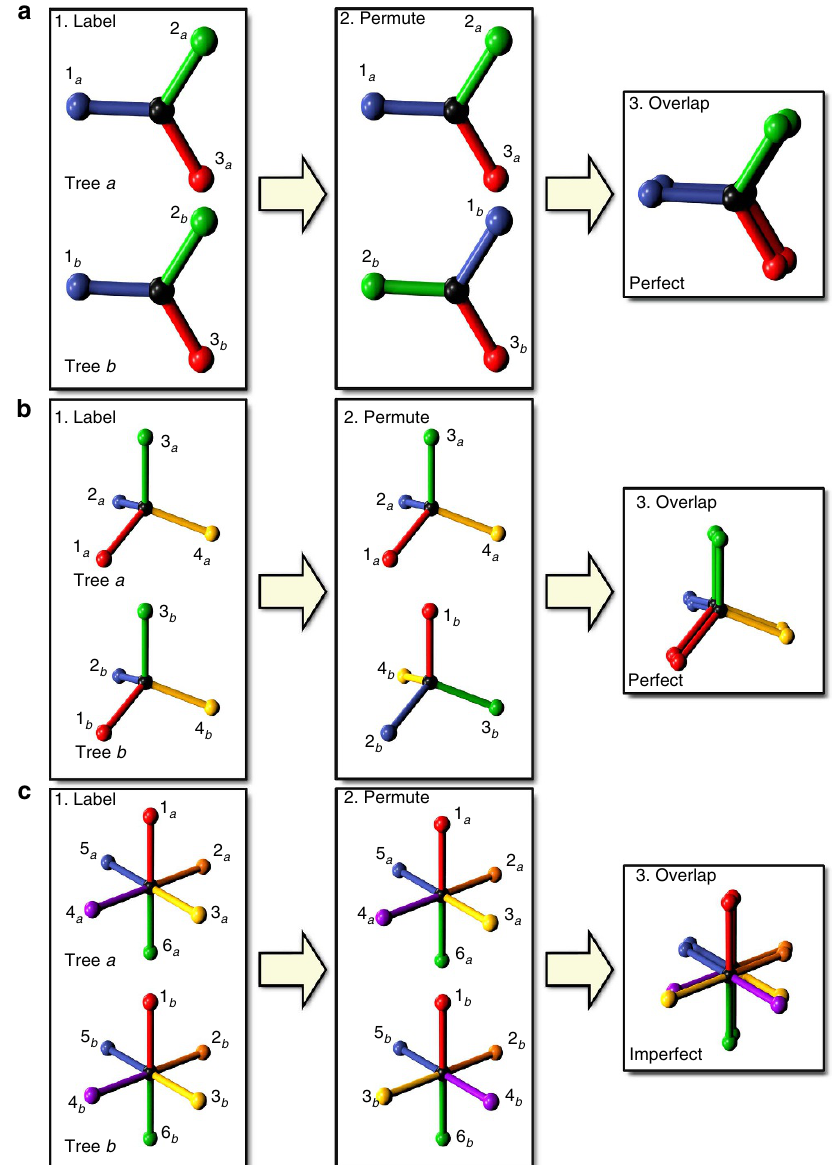
Figure 2 | Comparison of 1-trees illustrated with trihedra, tetrahedra and octahedra. Two identical trihedral trees ( a ) are labelled by their edges. The edges of tree b are then permuted. Tree b can then be rotated around the edge 3 b axis and made to perfectly overlap tree a . Similarly, two identical tetrahedral trees are labelled ( b ), and then the edges of tree b permuted. Reflection of tree B in the plane of edges 2 b and 4 b , followed by rotation around the new edge 3 b axis, brings the two trees into alignment. Two identical octahedral trees ( c ) can also be compared. We apply a permutation to tree B’s edges. When overlapped, the two trees are now mismatched; their yellow and purple edges are not aligned and cannot be made so by any congruent transformation without creating a new